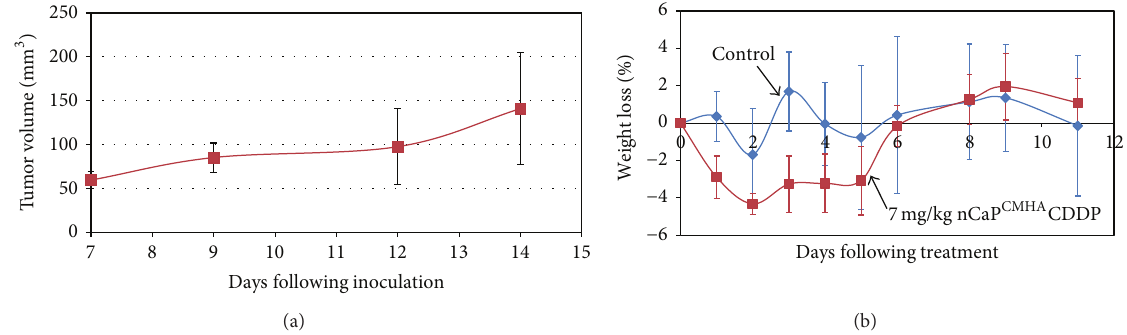
Figure 8: In vivo tumor take rate and maximum tolerable dose studies. (a) Tumor take rate study performed in athymic nude mice with 5 × 10 5 BT-47 4 cells injected subcutaneously in right rear flank of animals. Data represents average tumor volume versus days following EMT inoculation with standard deviations. (b) Maximum tolerable dose study conducted with athymic nude mice (6–8 weeks old) carrying BT- tumors. An intratumoral 7 mg/kg dose of nCaP CMHA CDDP (4 mice/group) was compared to an untreated control (4 mice/group). 47 4 EMT nCaP CMHA CDDP caused minimal weight loss at 7mg/kg and all animals recovered.